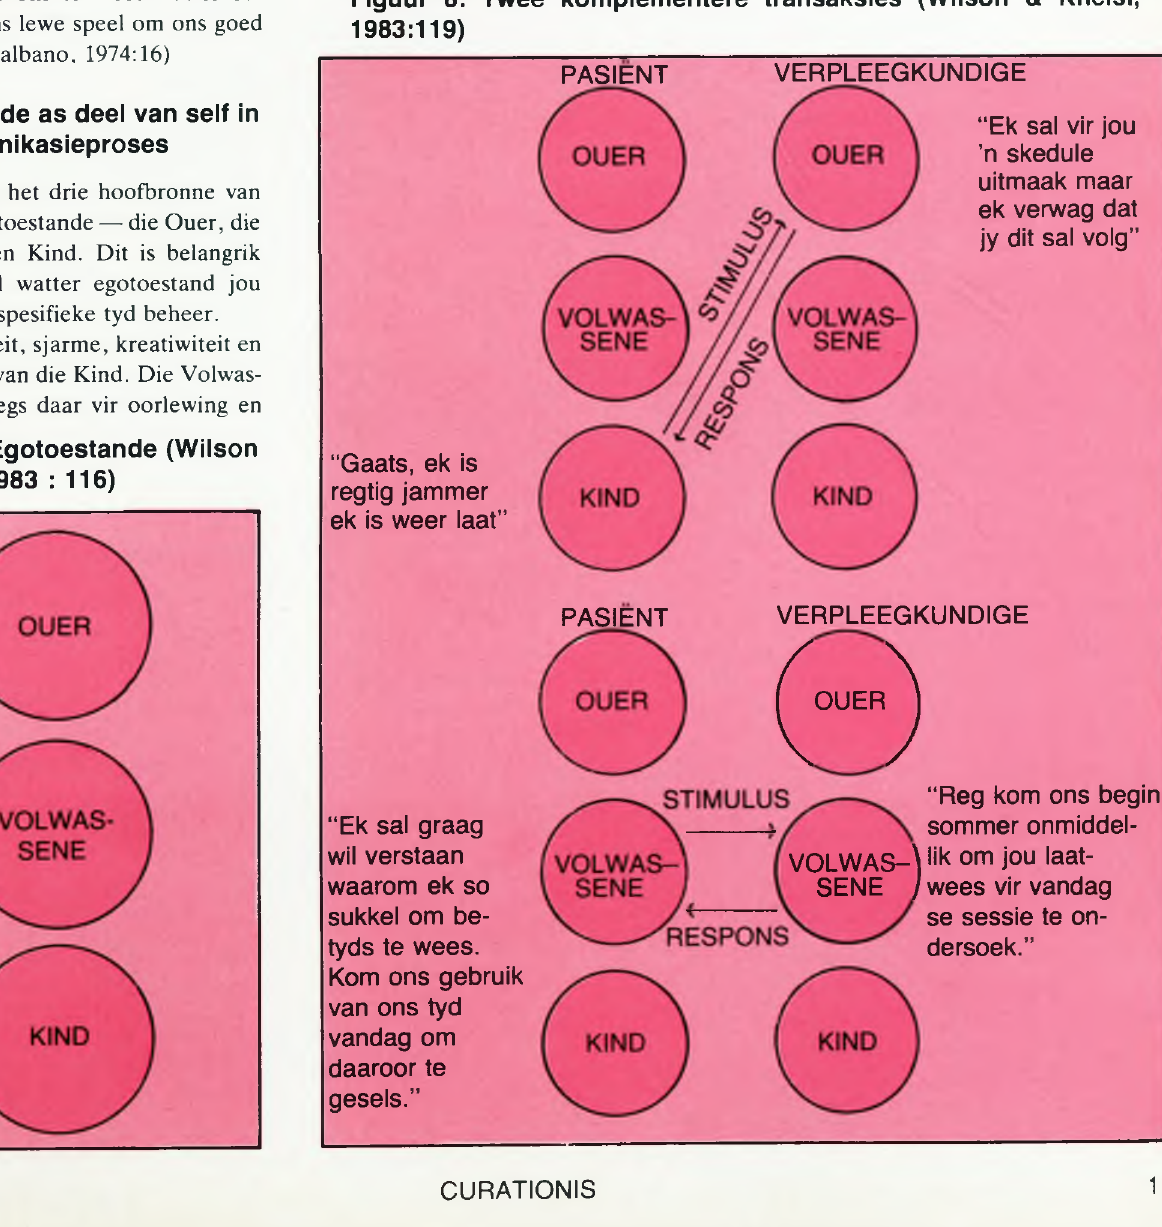
Figuur 8: Twee komplementêre transaksies (Wilson &